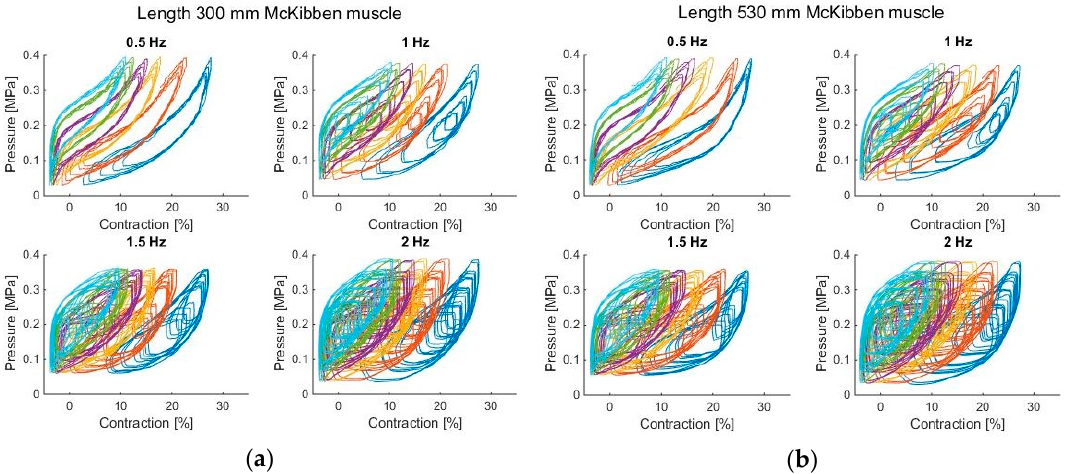
Figure 2. Hysteresis data at all dependencies: ( a ) McKibben muscle of 300 mm and ( b ) McKibben muscle of 530 mm.